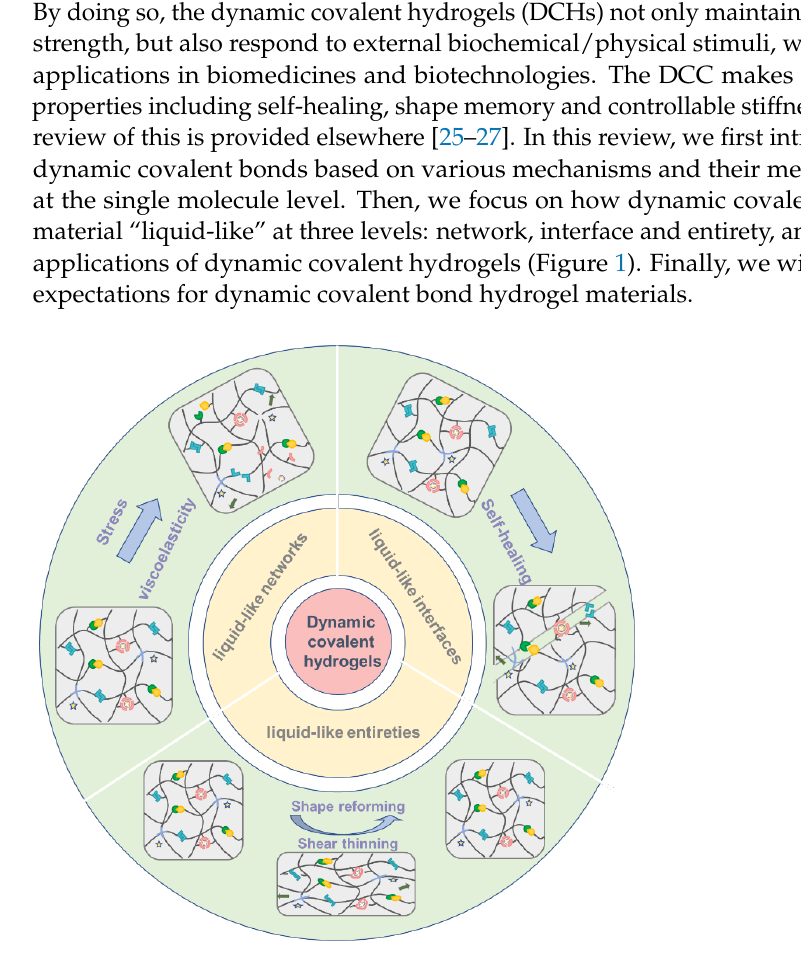
Figure 1. Dynamic covalent chemistry endows hydrogels with more liquid-like properties.